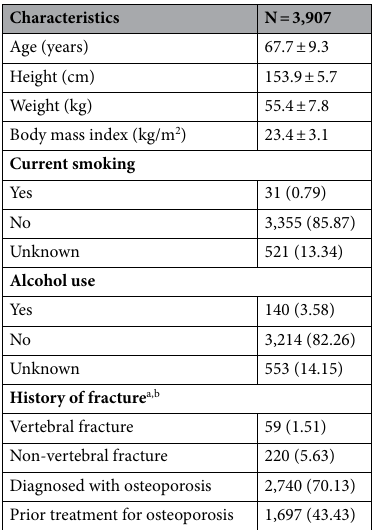
Table 1. Baseline characteristics of the study participants. Data are presented as mean ± SD or number (percentage). a SOC (System Organ Class), coding by Medical Dictionary for Regulatory Activities (MedDRA ver. 20.1). b Overlapping count.